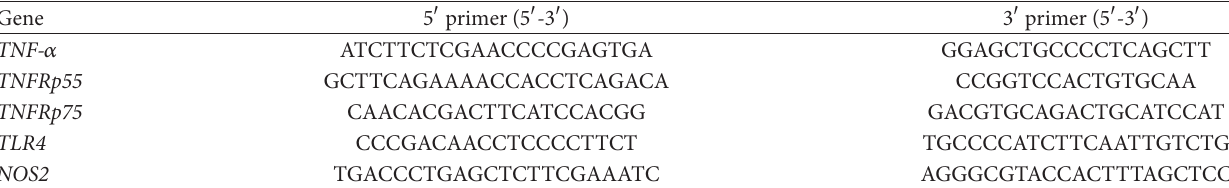
Table 1: Summary of primers sequences used for